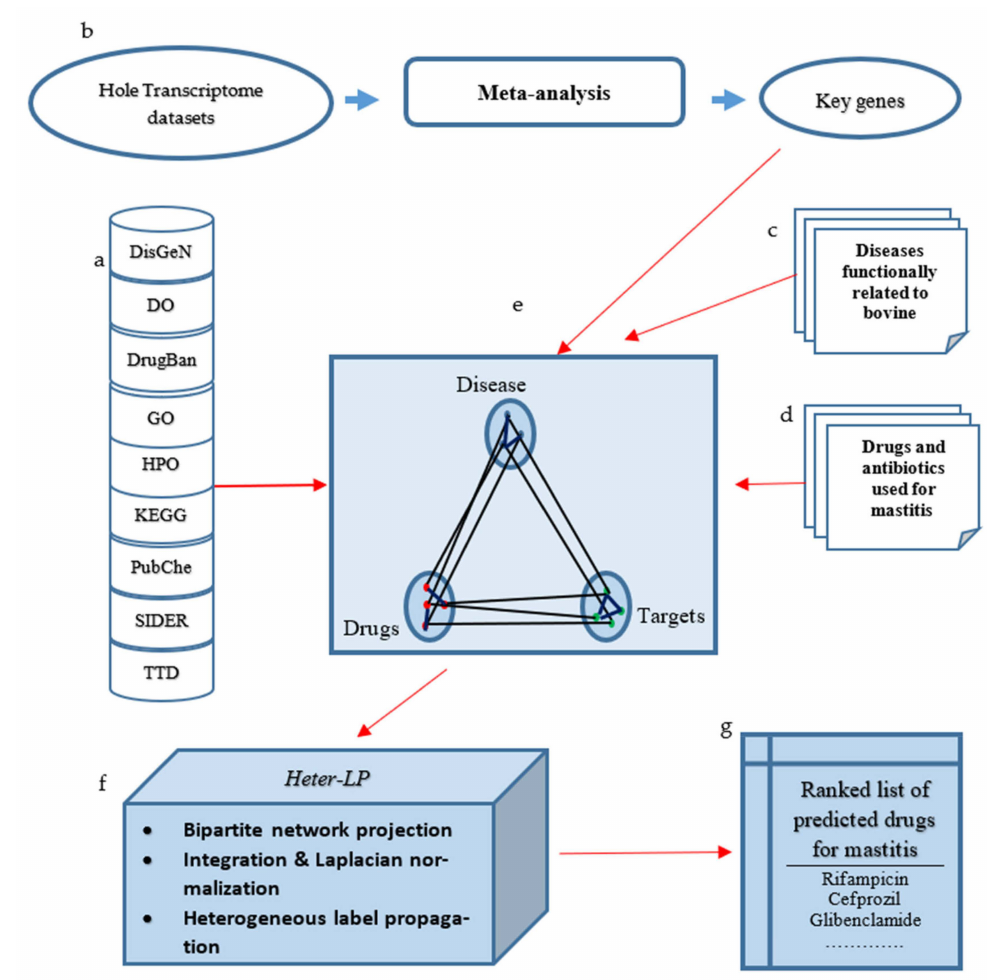
Figure 1. The workflow for this research. ( a ) Data related to diseases, drugs, and their targets gathered from different data sources (Table 1). ( b ) Key genes with robust bio-signatures and key regulatory ef- fects in response to E. coli (Table 2). ( c ) Diseases or biological processes functionally related to mastitis identified by using the Pathway Studio web tool (Figure 2). ( d ) Drugs and antibiotics relevant to E. coli mastitis gathered by literature mining (Table 3). ( e ) A suitable heterogeneous network constructed by integration of data from parts A, B, C, D ( f ) Running the Heter-LP algorithm on the constructed network to predict important relations involved in mastitis (described in Section 2.2). ( g ) Predicted drugs, ranked according to their score computed by Heter-LP (Table 4 and Supplementary Table